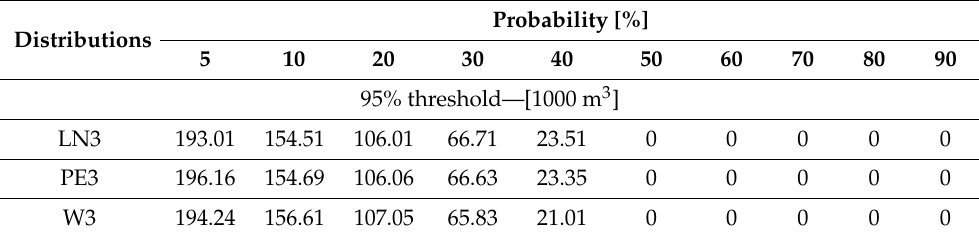
Figure 9. The probability distribution curves for annual deficit volume. Table 10 presents the result values of quantiles for annual deficit volume. Table 10. Quantile results for annual deficit volume.